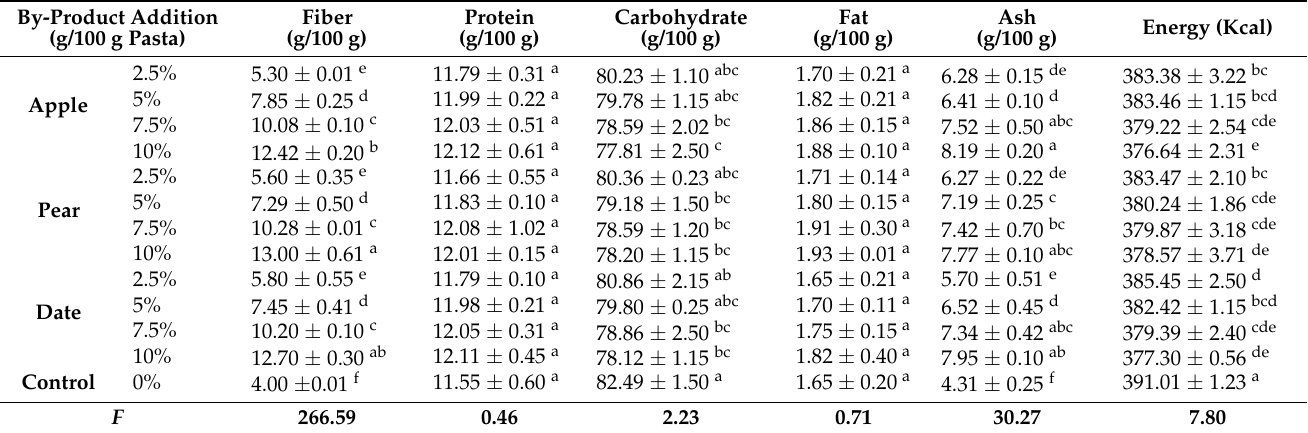
Table 1. Chemical composition of pasta and calculated nutritional